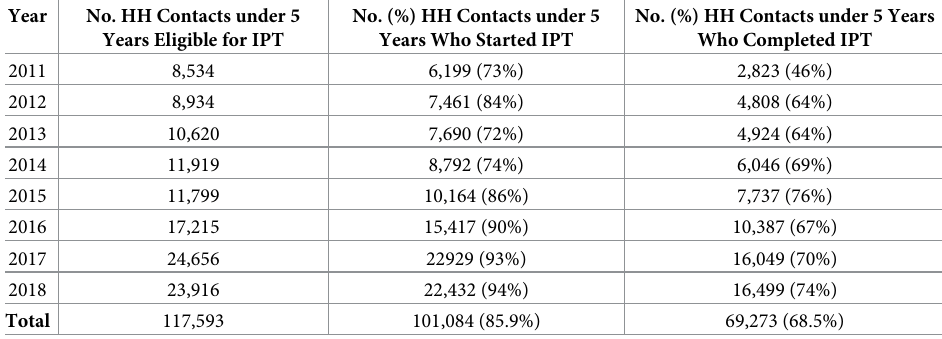
Table 4. IPT enrollment and completion rate for children under age